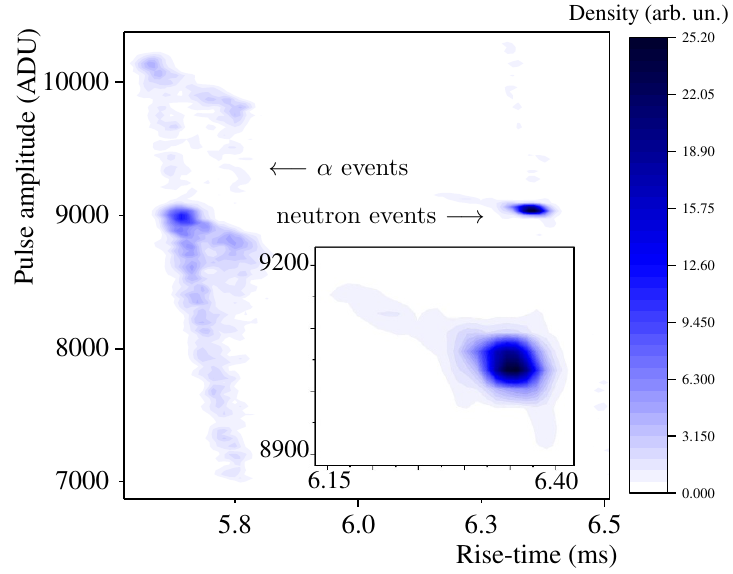
Figure 9 . In this density plot, pulse amplitude as a function of the rise-time is shown for pulses acquired with Detector 1 of table 1. The (cid:11) -like events are selected with the light detector. Therefore, only events induced by the uranium (cid:11) source and those corresponding to neutron captures on 6 Li are contained in the plot. A zoom of the neutron-capture population is shown in the